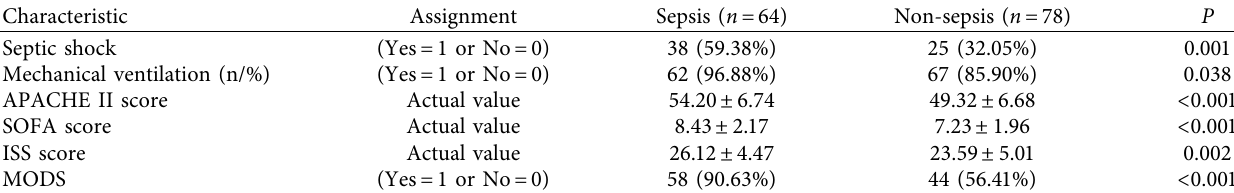
Table 6: Multivariate logistic regression analysis of independent risk factors for the death for patients with post-traumatic sepsis.